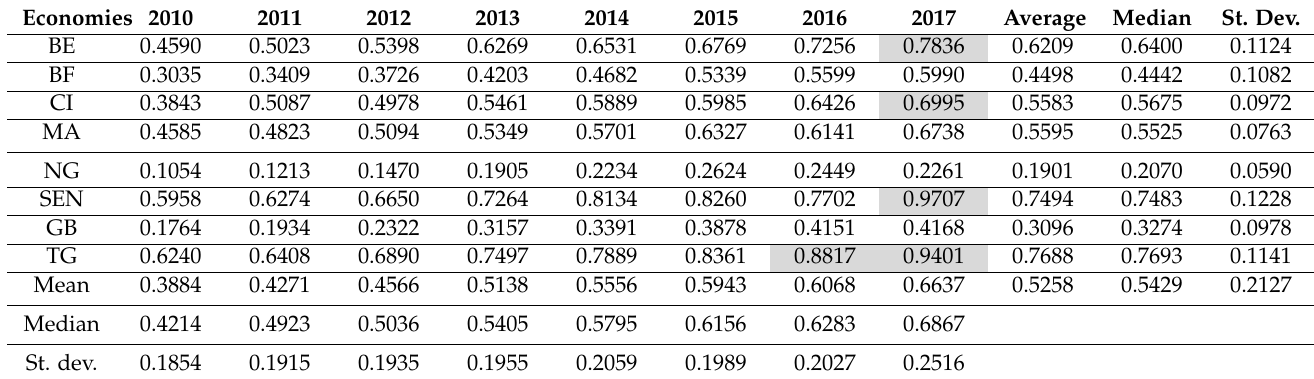
Table 6. AS–CEB—Descriptive analysis.